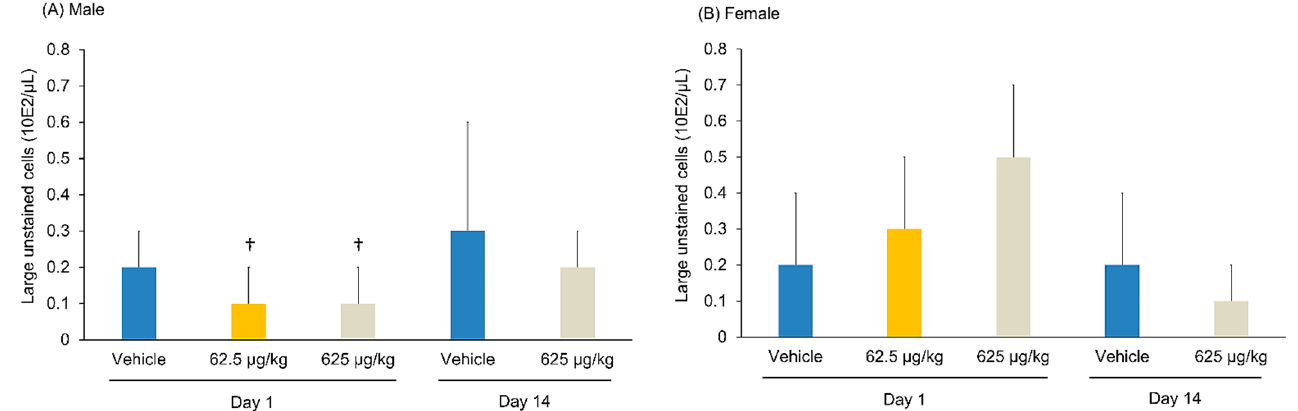
Figure 6. Changes in the number of large unstained cells in the blood after the intraperitoneal administration of Cu-NCAB001 into mice. ( A ) Male. ( B ) Female. Values are presented as mean ± SD. The means were calculated based on the following number of values: day 1, vehicle and 625 μ g/kg groups, n = 15; 62.5 μ g/kg group, n = 10; day 14, vehicle and 625 μ g/kg groups, n = 5. As there were no significant differences in histopathological observations between the 625 μ g/kg-treated and control groups on Day 1, the 62.5 µ g/kg-treated group was not subjected to assessment on Day 14. † p ≤ 0.05 vs. vehicle group on the same day (Dunnett test, two-side).